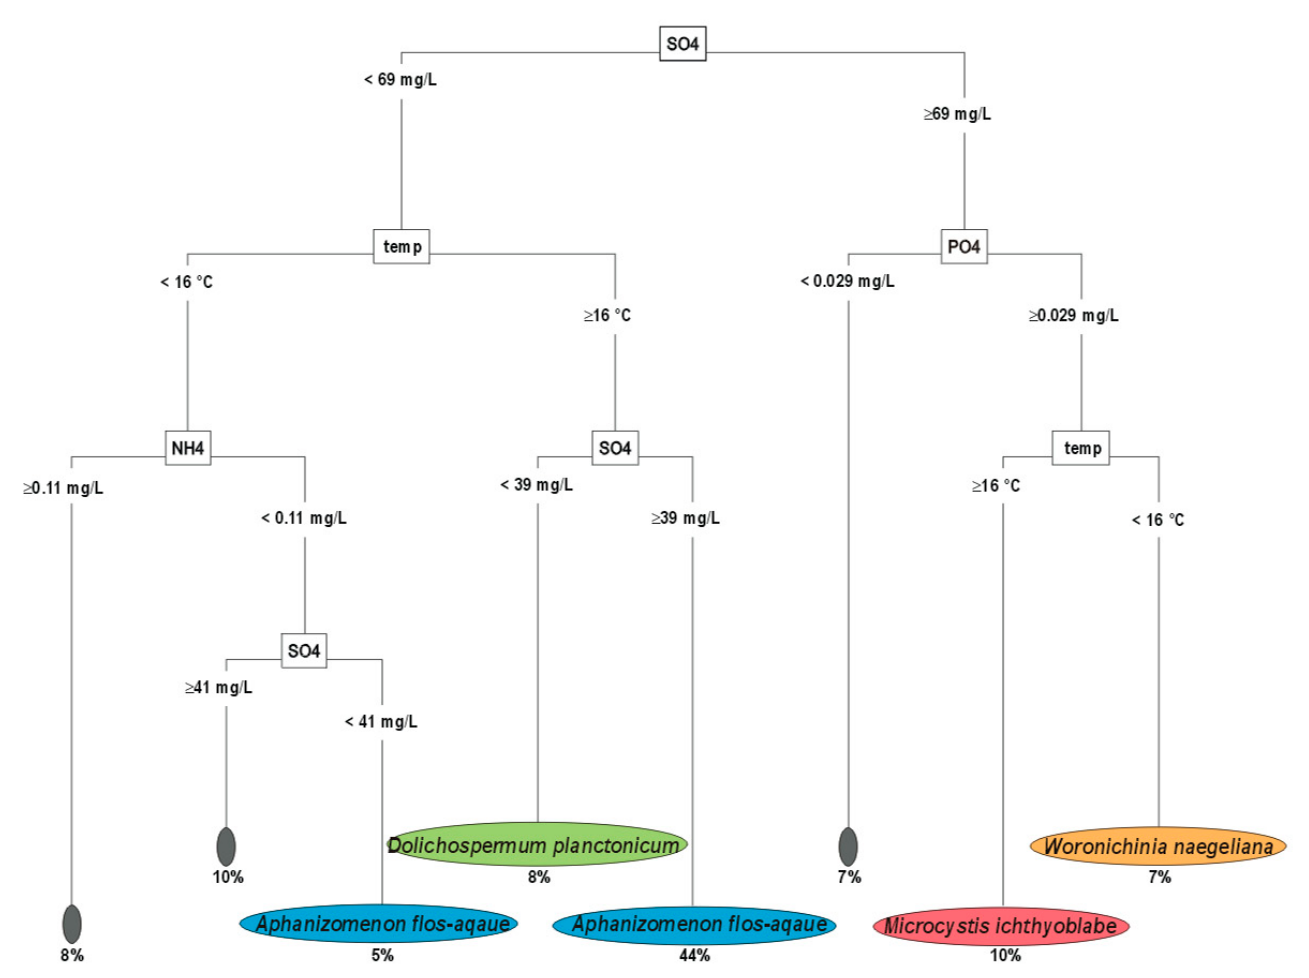
Figure 1. Decision tree of factors explaining the dominance of cyanobacterial species—upper layer. Small grey boxes—no dominant cyanobacteria; blue and green boxes—dominance of filamentous diazotrophic cyanobacteria ( A. flos-aquae , D. planctonicum ); red and orange boxes—dominance of Chroococcales ( M. ichthyoblabe , W. naegeliana